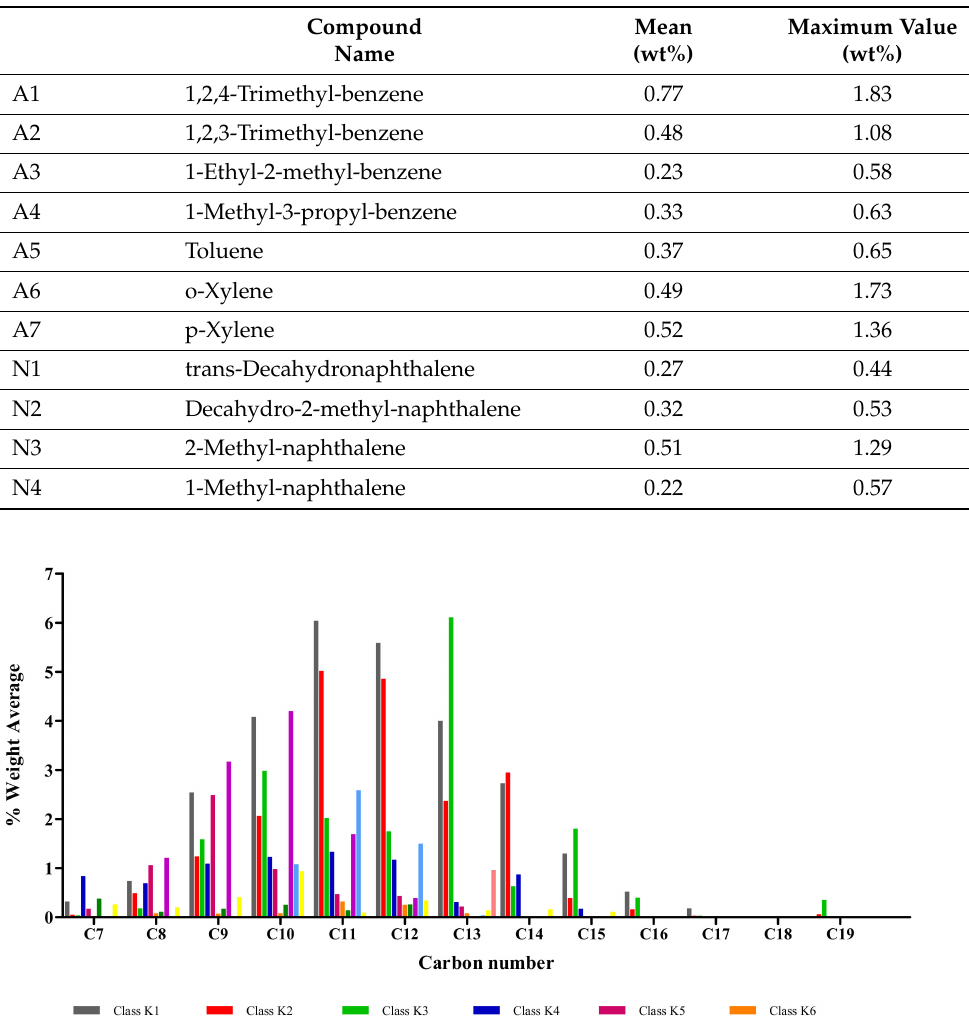
Table 5. Main individual components. Aromatic and naphthalene compounds.